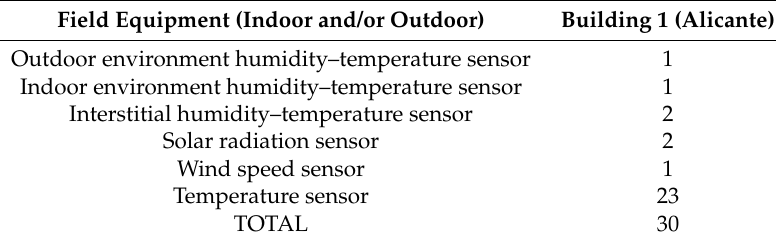
Table 2. General organization of the sensor system to monitor type C